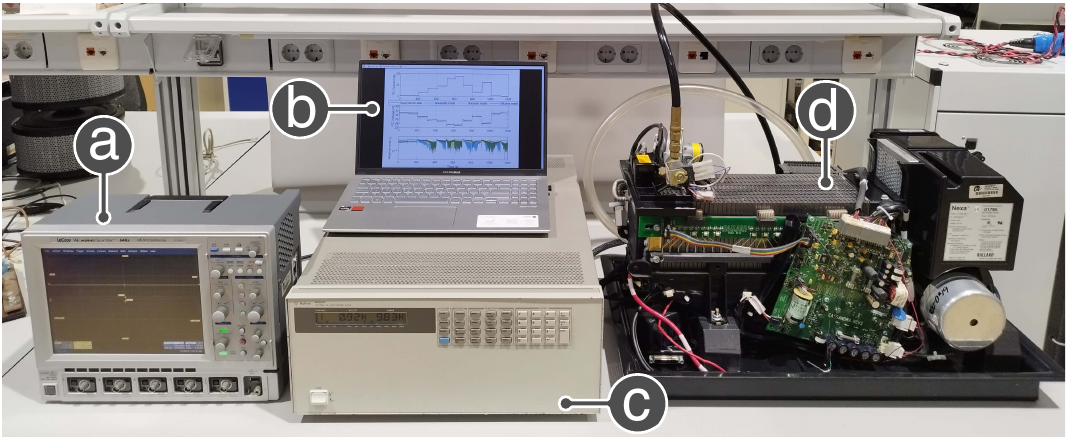
Figure 2. Experimental data acquisition configuration used for the phases of training and validation of the SVM model: ( a ) LeCroy WaveSurfer 64Xs-A oscilloscope, which saves trace data to an internal memory location, ( b ) laptop computer + LabVIEW program to control the electronic load using the National Instruments GPIB-USB-HS+ software program to monitoring the Nexa Fuel Cell, ( c ) Agilent 6050A Electronic load, and ( d ) Nexa power module from Ballard Power